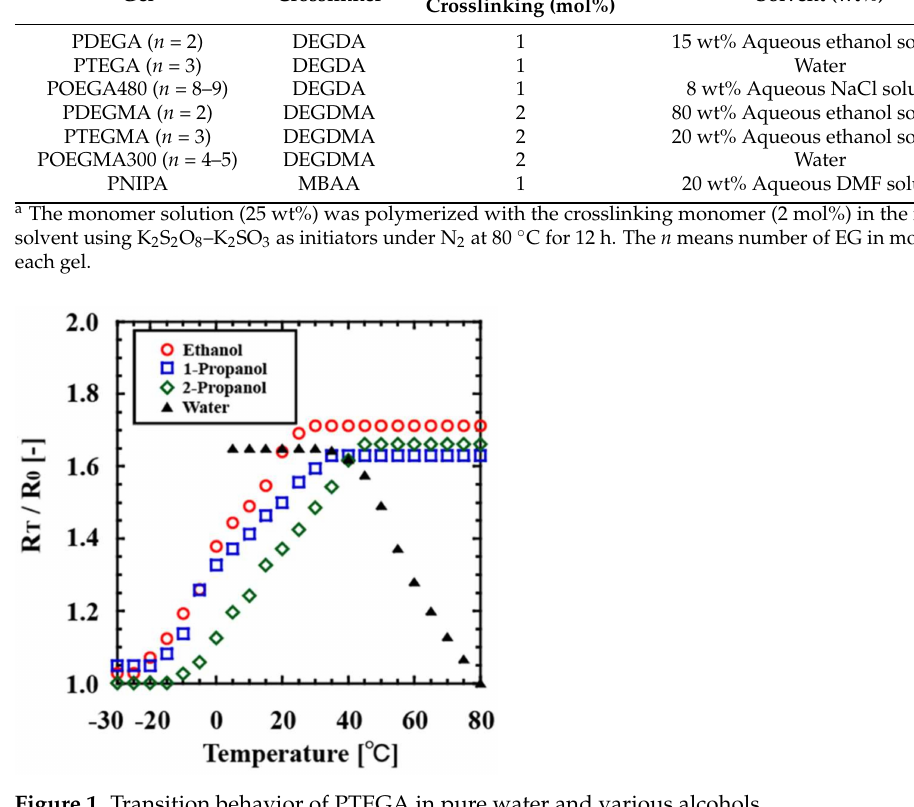
Figure 1. Transition behavior of PTEGA in pure water and various